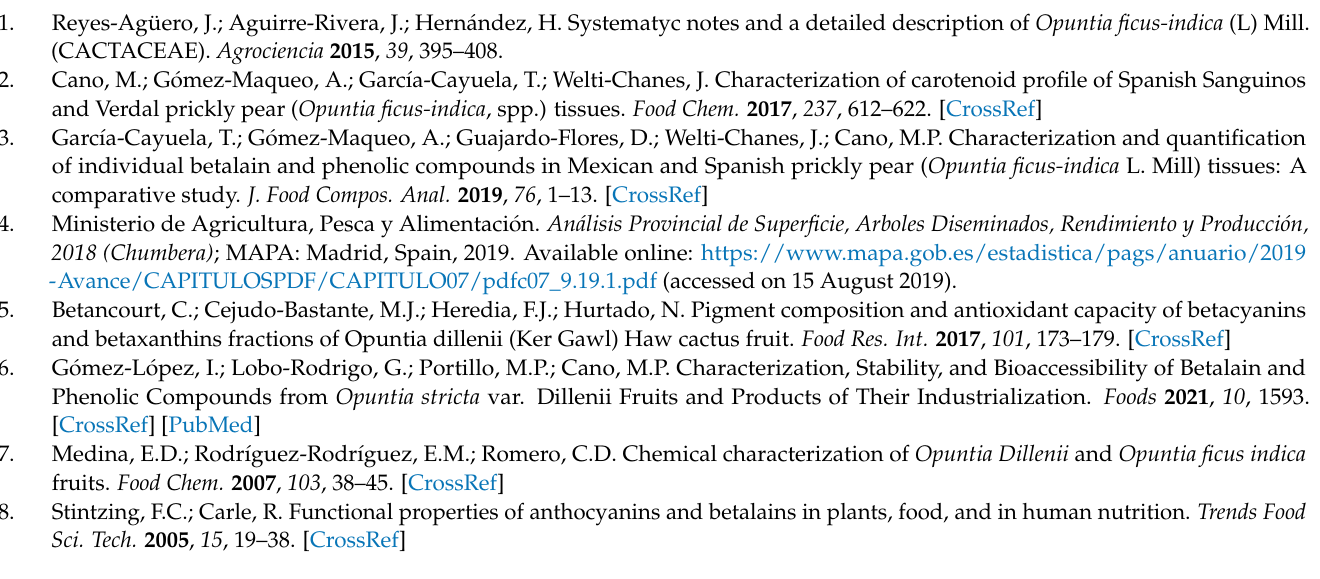
stricta var. Dillenii ’s prickly pears from Canary Island, Table S2: Individual betalain and phenolic Table S3: Major bioactive compounds of Opuntia stricta var. Dillenii chromatographic identification (retention time (Rt), maximum absorption ( λ max), masa spectra according to Gomez-Lopez et al., (2021), Table S4: Analysis of variance and model fitting regression coefficient of independent variables (ethanol volume (%) in solvent ( v / v ), amplitude (%) and temperature ( ◦ C)) about the extraction yield (%) and content (mg/g dry weight) of most abundant betalains, piscidic acid and flavonoids obtained at 5 min UAE